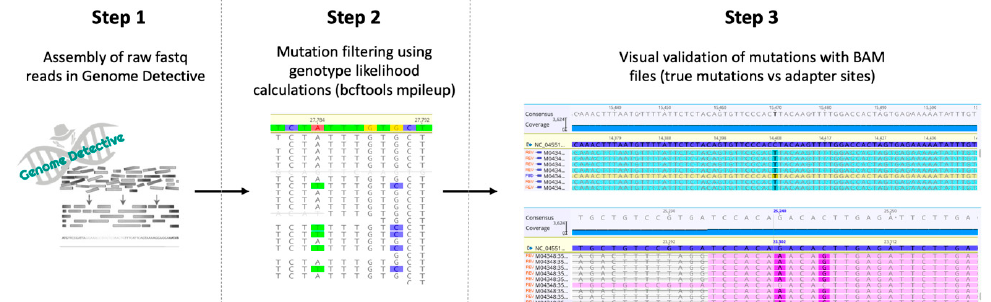
Figure 2. Three-step workflow for generation of high-quality genomes. Step 1: Raw reads from Illumina and Nanopore sequencing were assembled by using the web-based Genome Detective 1.126 (https://www.genomedetective.com/) platform and its coronavirus typing tool. Step 2: The initial assembly obtained from Genome Detective was polished by aligning mapped reads to the references and filtering out mutations with low genotype likelihoods, using bcftools 1.7-2 mpileup method. This calculation determines the probability of a genotype at sites containing reads with various bases (e.g., the probability that position 27,784 is A vs. T in illustration above). Step 3: All mutations were validated visually with BAM files viewed in Geneious software, to ensure that called mutations were true and not part of lingering adapter sites.